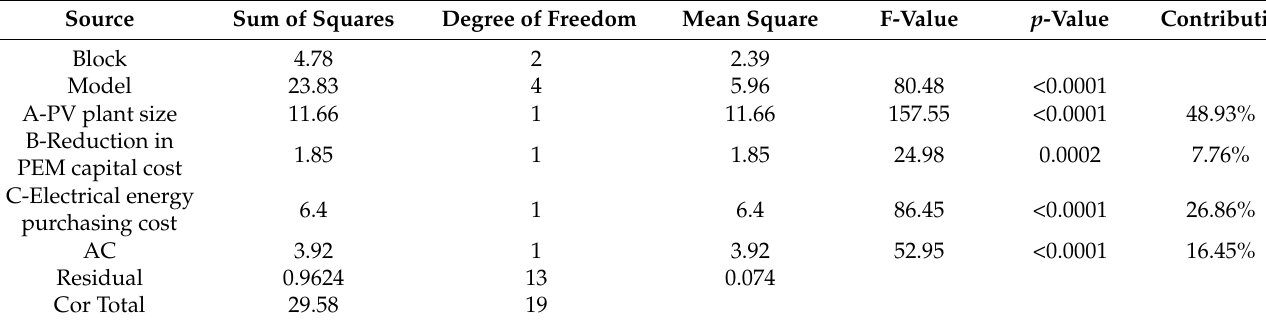
Table 11. ANOVA for the reduced 2FI